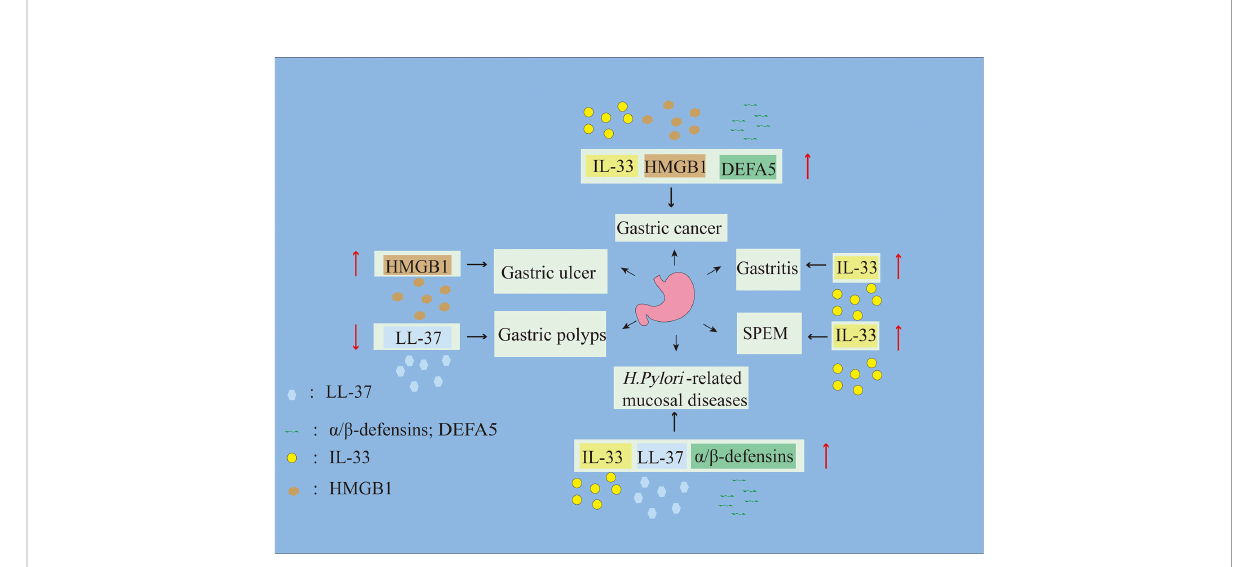
FIGURE 1 Alarmins are involved in the progression of gastric mucosal diseases. Up arrows represent alarmin upregulation, and down arrows represent alarmin